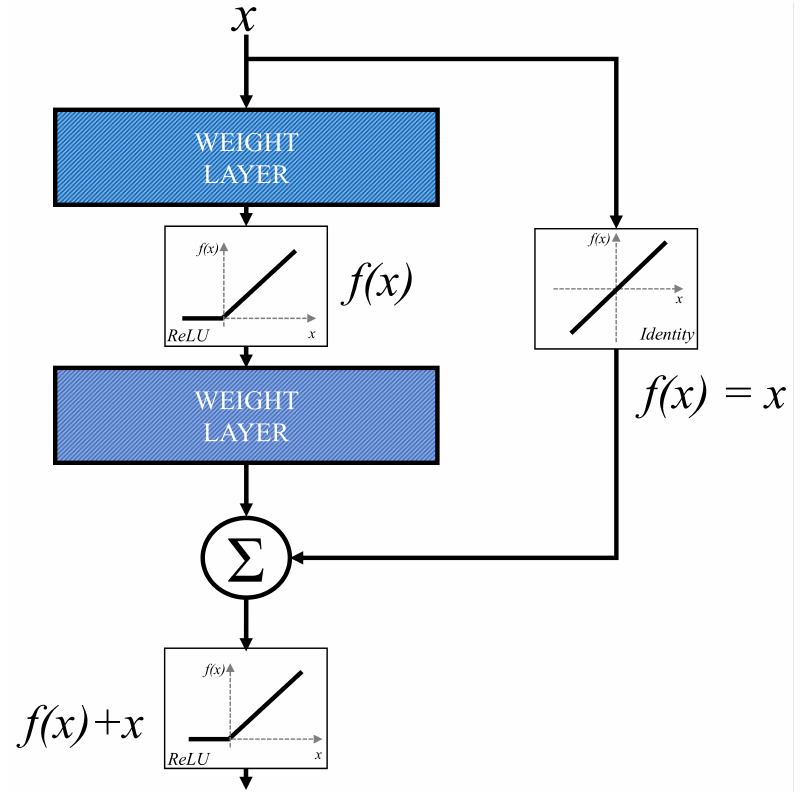
Figure 8. A block scheme of a residual